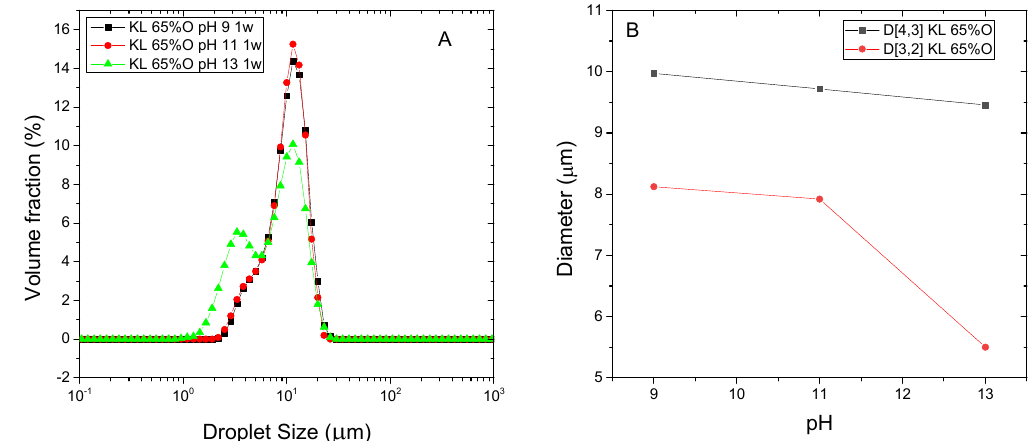
Figure 5. Droplet size distribution ( A ) and characteristic mean diameters ( B ) of silicone oil emulsions stabilized by Kraft lignin as function of pH. All emulsions were formulated with 65 wt.% O, stabilized by 0.5 wt.% lignin and measured after 1 week storage.